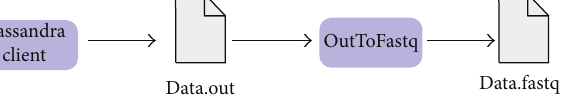
Figure 3: Stages of